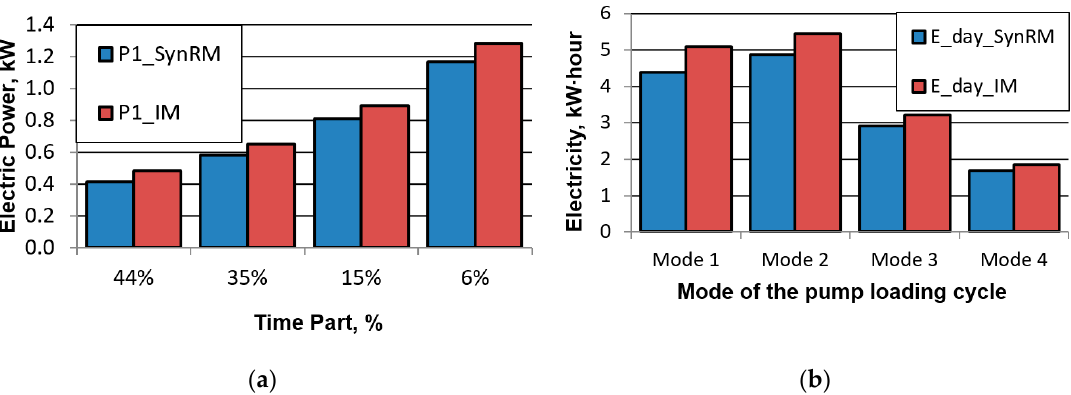
Figure 17. ( a ) Power consumption by various types of drive in the pump load cycle; ( b ) Energy Figure 17 consumption per day by various types of drive in the pump load